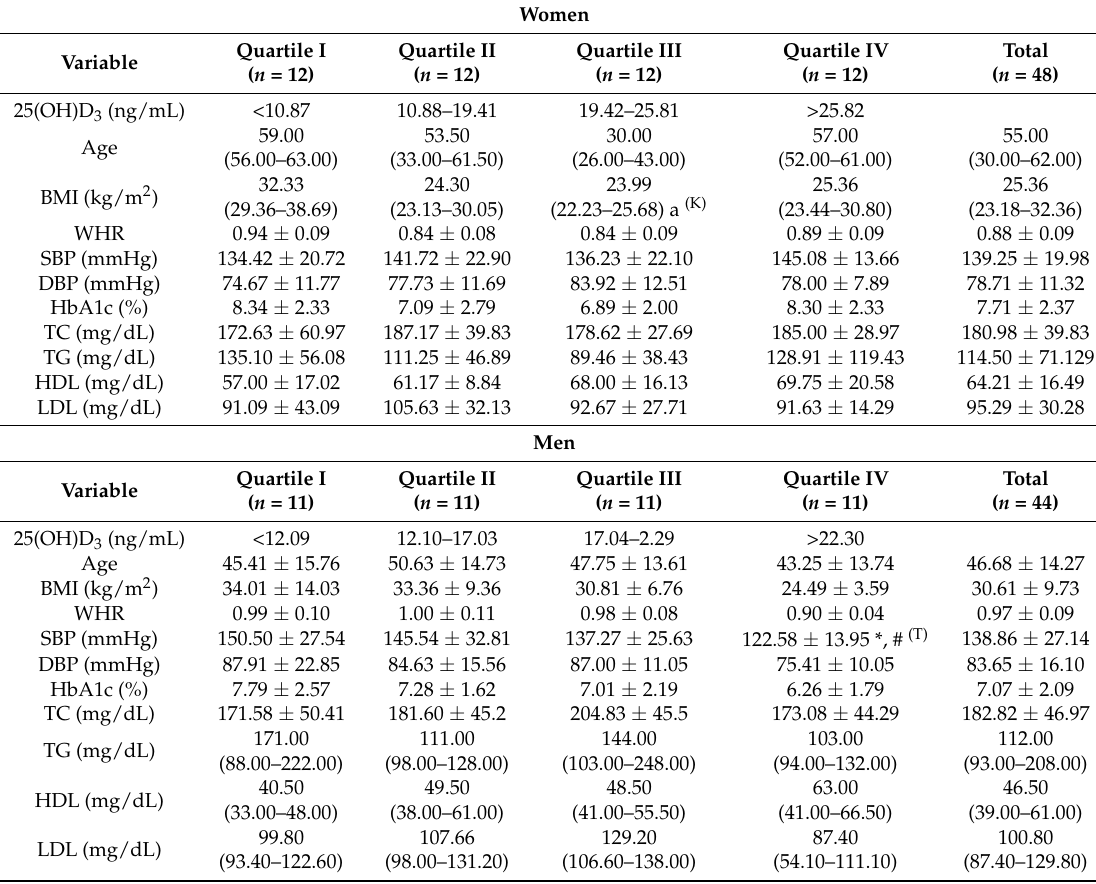
Table 1. The general characteristics of type 2 diabetic patients according to 25(OH)D 3